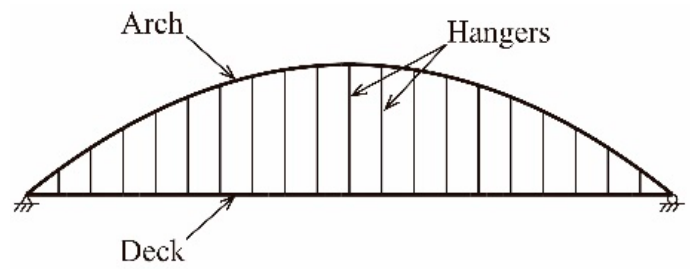
Figure 1. Structural elements of a tied-arch bridge.